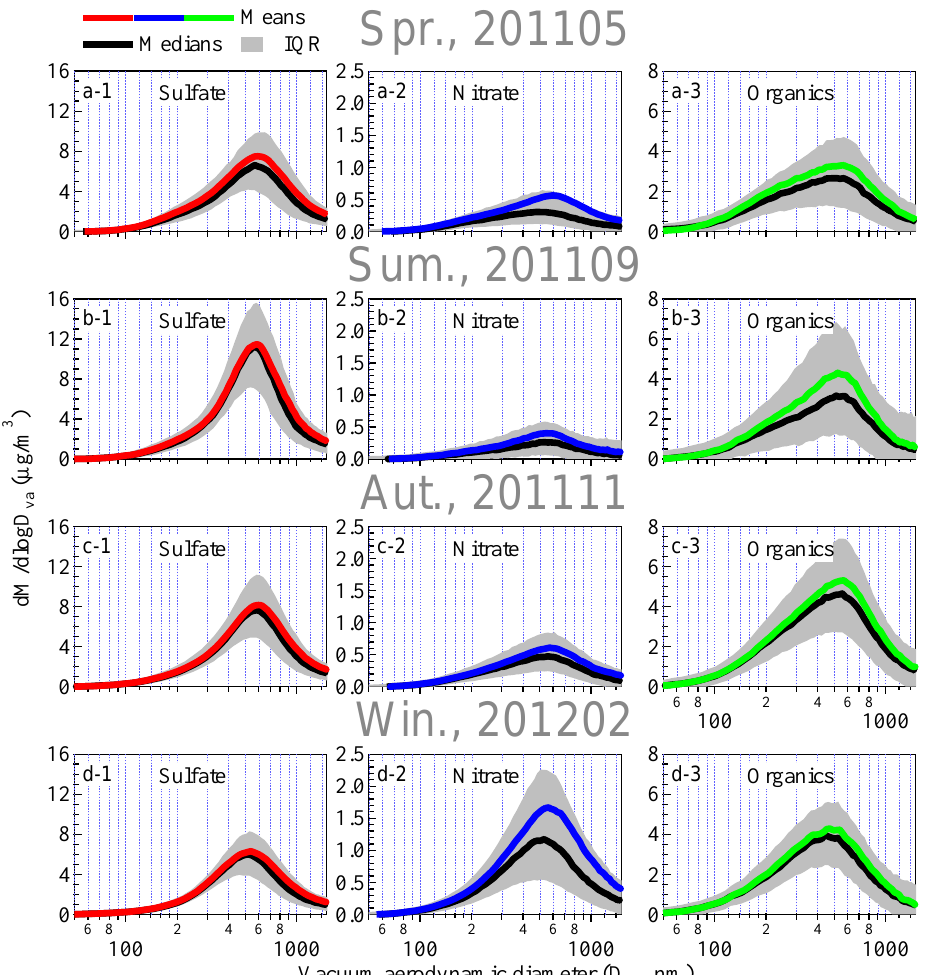
Figure 3. Size distributions of sulfate (SO 4 ), nitrate (NO 3 ), and organics (Org) in the 4 months. The red, blue, and green lines are the means; the black lines are the medians; and the grey areas are the interquartile ranges (IQRs). Figure 3 Size distributions of sulfate (SO4), nitrate (NO3), and organics (Org) in the four months. The 3 red, blue and green lines are the means, the black lines are the medians, and the grey areas are the 4 that coincided with the fast economic development interquartile ranges (IQRs). 5